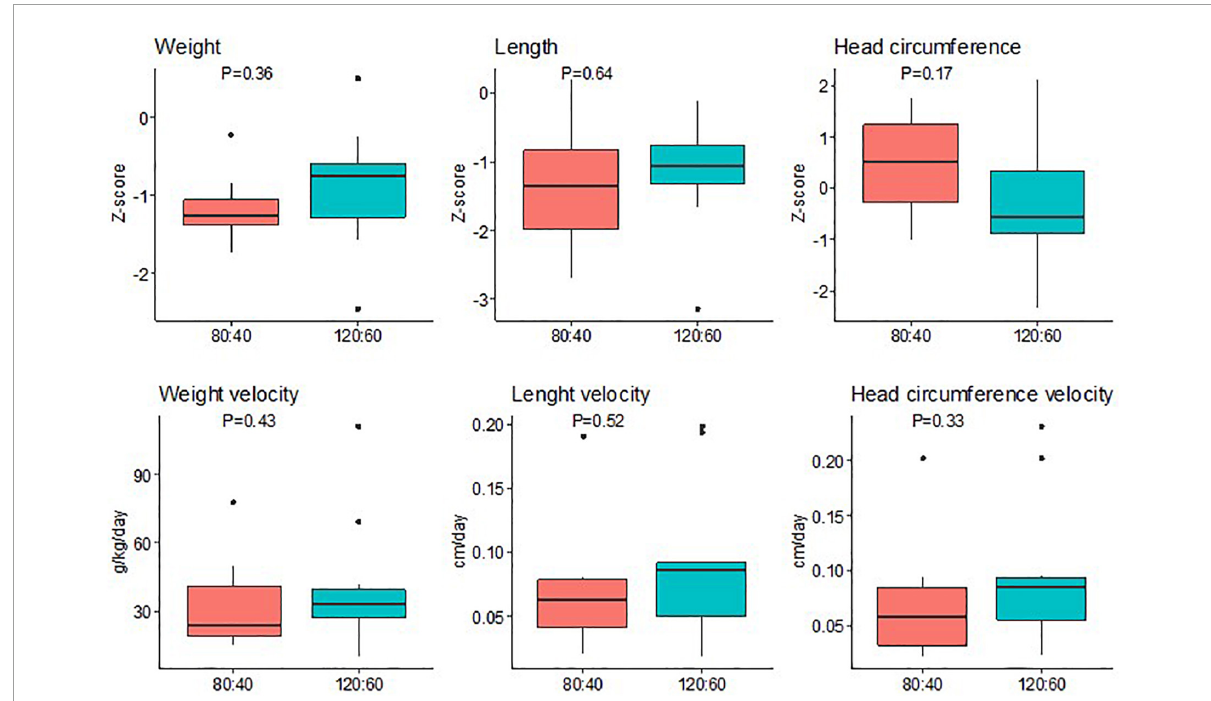
FIGURE4 Neonatal differences in Z-score between 36 weeks’ postmenstrual age and birth and growth velocities in weight, length, and head circumference according to the ARA:DHA group supplementation. Data show median and interquartile range [Q1; Q3]. The p -value was extracted from Mann–Whitney